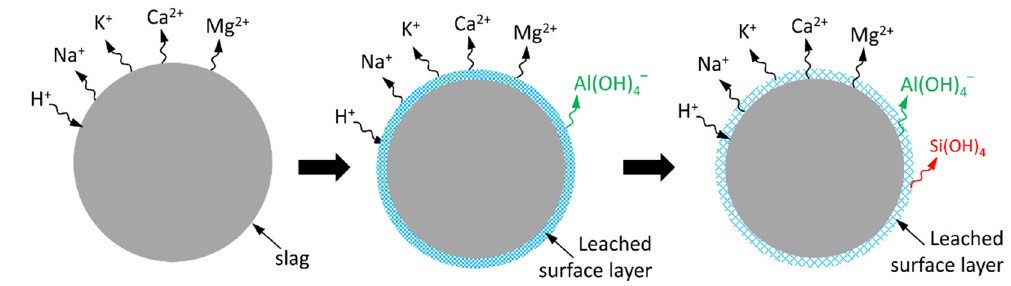
Figure 10. Schematic representation of the formation of the leached surface layer.